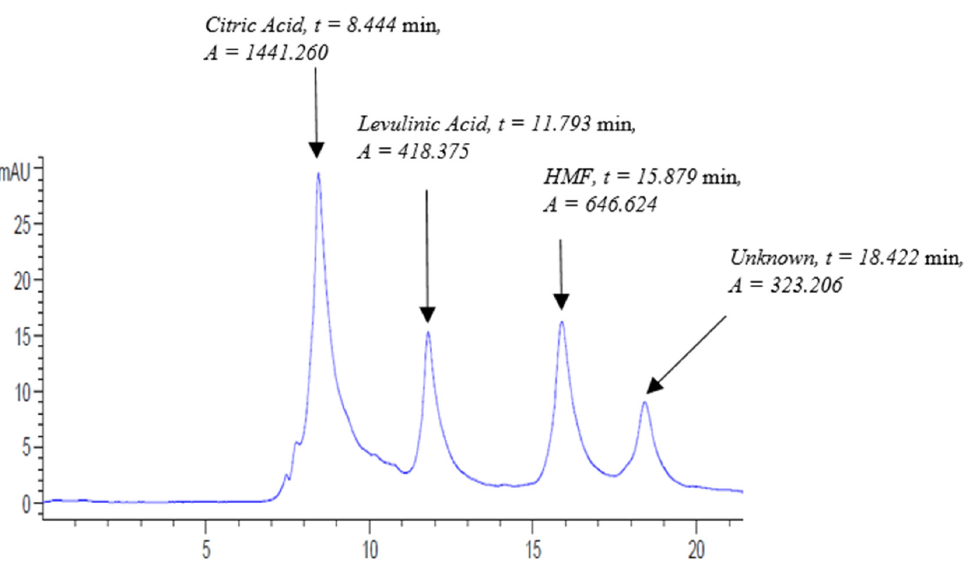
Figure 1. Mixed standard solution STD2 chromatogram run at UV-210 nm at the following condi- tions: flow rate, 0.3 mL/min; column temperature, 30 °C; and run time, 20 min. The remaining chromatograms of the used mixed standard solutions are listed in the Supplementary Material (Figures S15 and S16).